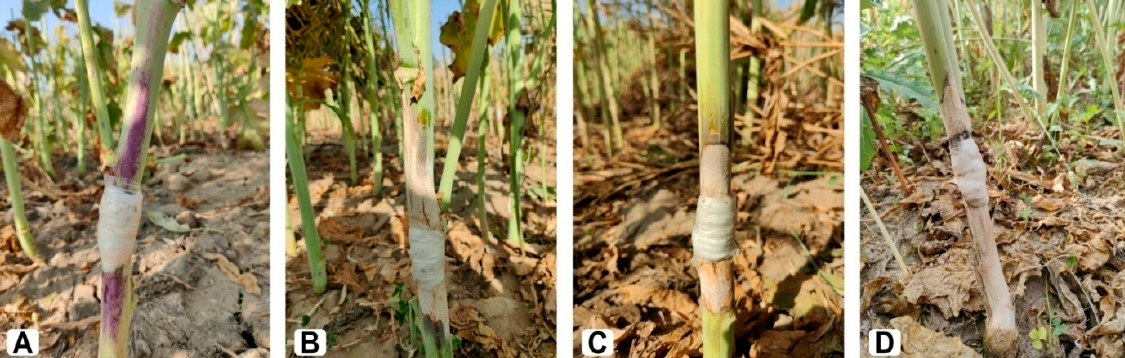
Figure 2. Sclerotinia stem rot response of the two parental Indian mustard genotypes, resistant DRMR 2035 ( A ) and susceptible RH 1569 ( B ), and their moderately resistant F 1 hybrid RH 1569 × DRMR 2035 ( C ) in comparison with highly susceptible commercial cultivar RH 0749 ( D ).